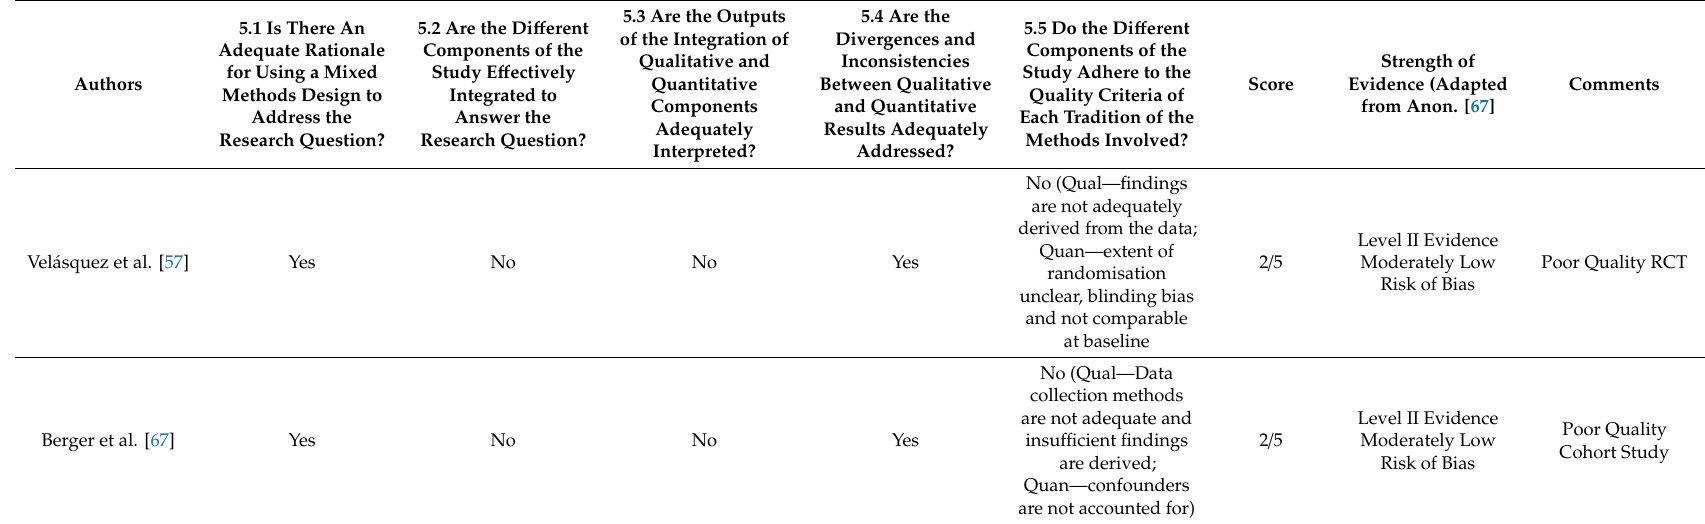
Table 5. Quality Assessment for Mixed Methods Studies using MMAT